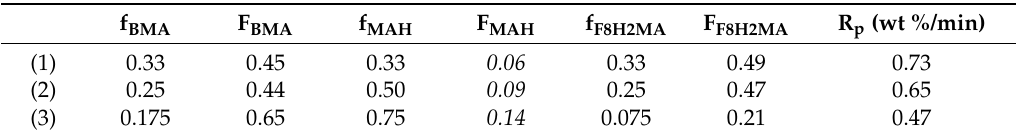
Table 4. Composition of monomer mixtures and terpolymers, as well as initial weight rates of polymerizations measured with BMA/F8H2MA/MAH.